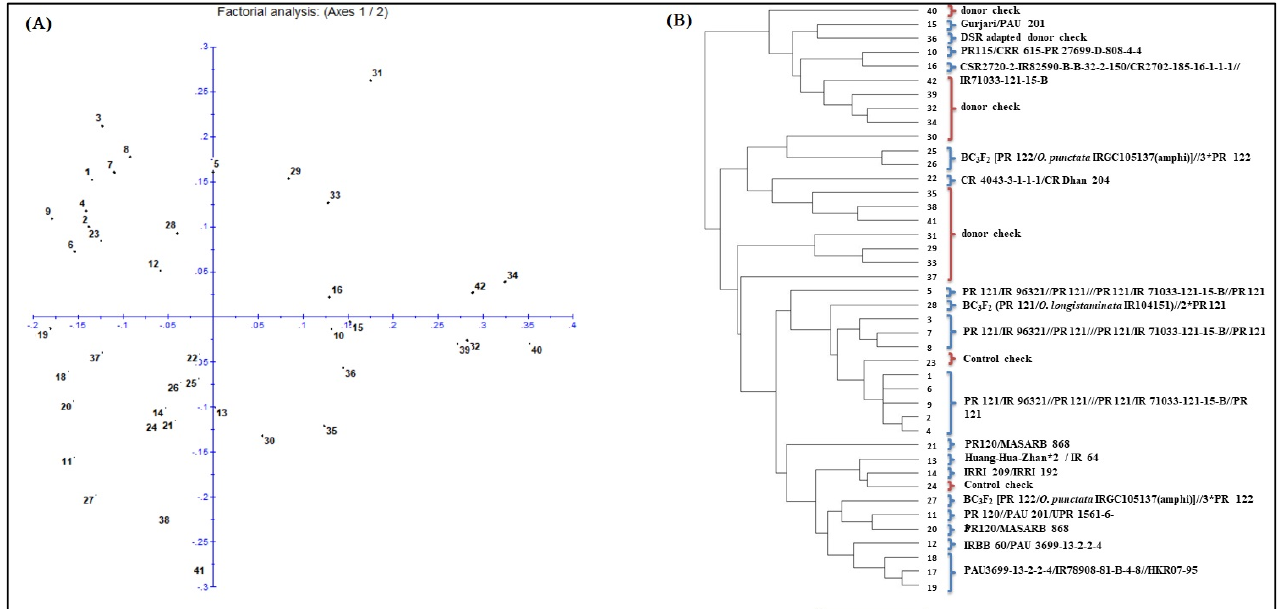
Figure 3. ( A ) Principal component analysis of the advanced breeding panel (13 DSR adapted donor checks, 2 control checks, and 27 advanced breeding lines). ( B ) Phylogenetic analysis of the 42 accessions (13 DSR adapted donor checks, 2 control checks, and 27 advanced breeding lines) using 116 KASP assay DNA fingerprinting database. The parentage of the advanced breeding lines is indicated in the phylogenetic tree (Figure 3B, right side). The numerical code represents the breeding panel constituting the advanced breeding lines/donor check/control checks in the breeding panel.